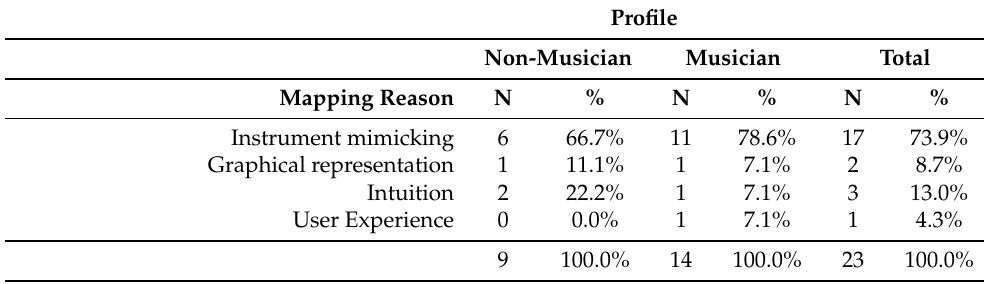
Table A18. Mapping rationale—stimulus b.